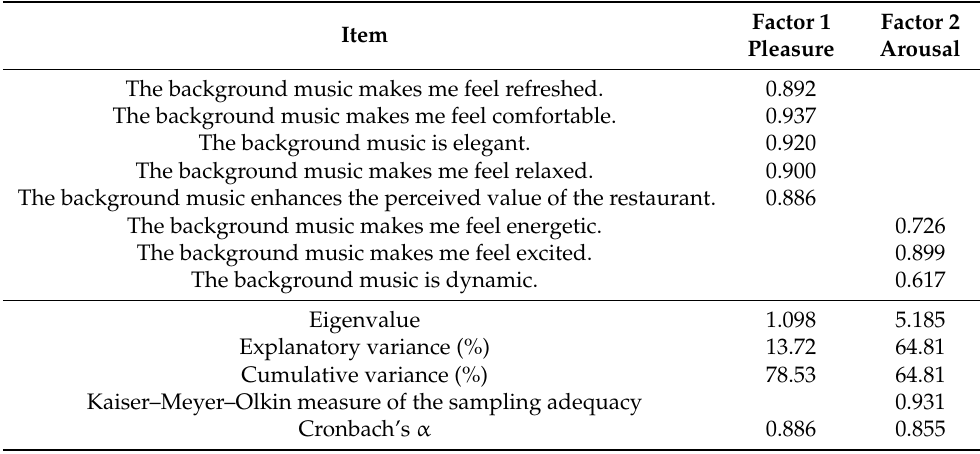
Table 2. Factor analysis of the evaluation scale for the emotions during the dining experience.